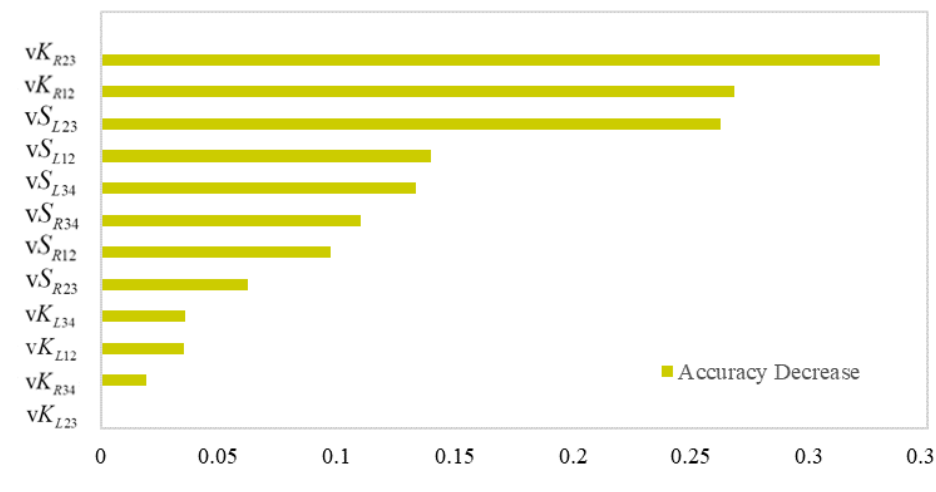
Figure 2. Variable importance in random forest.